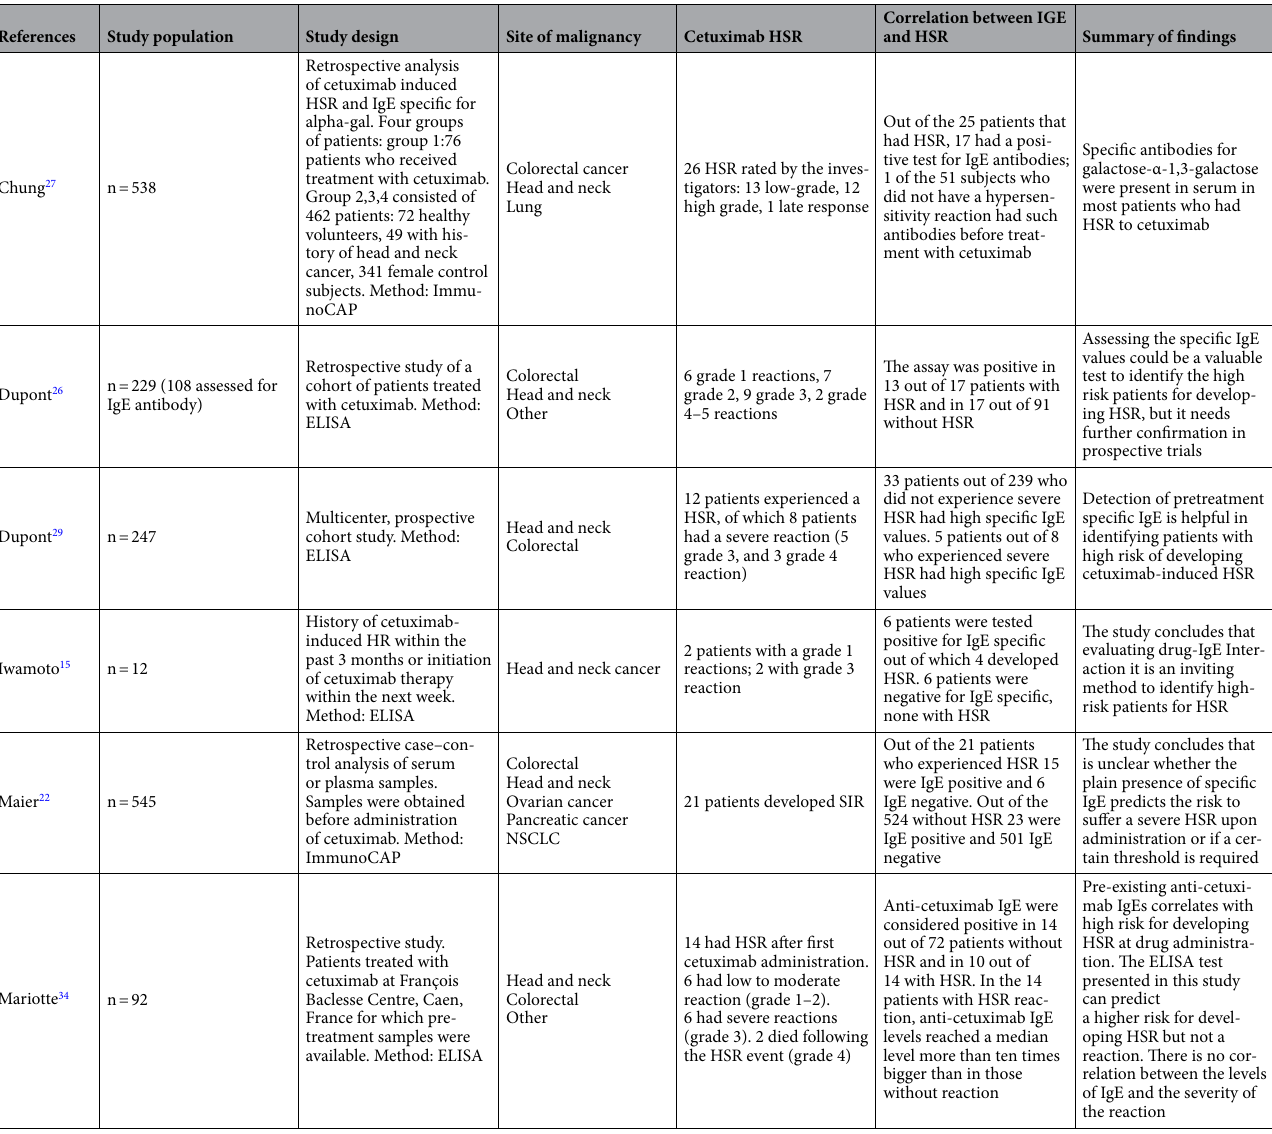
Table 1. Characteristics of the 6 included